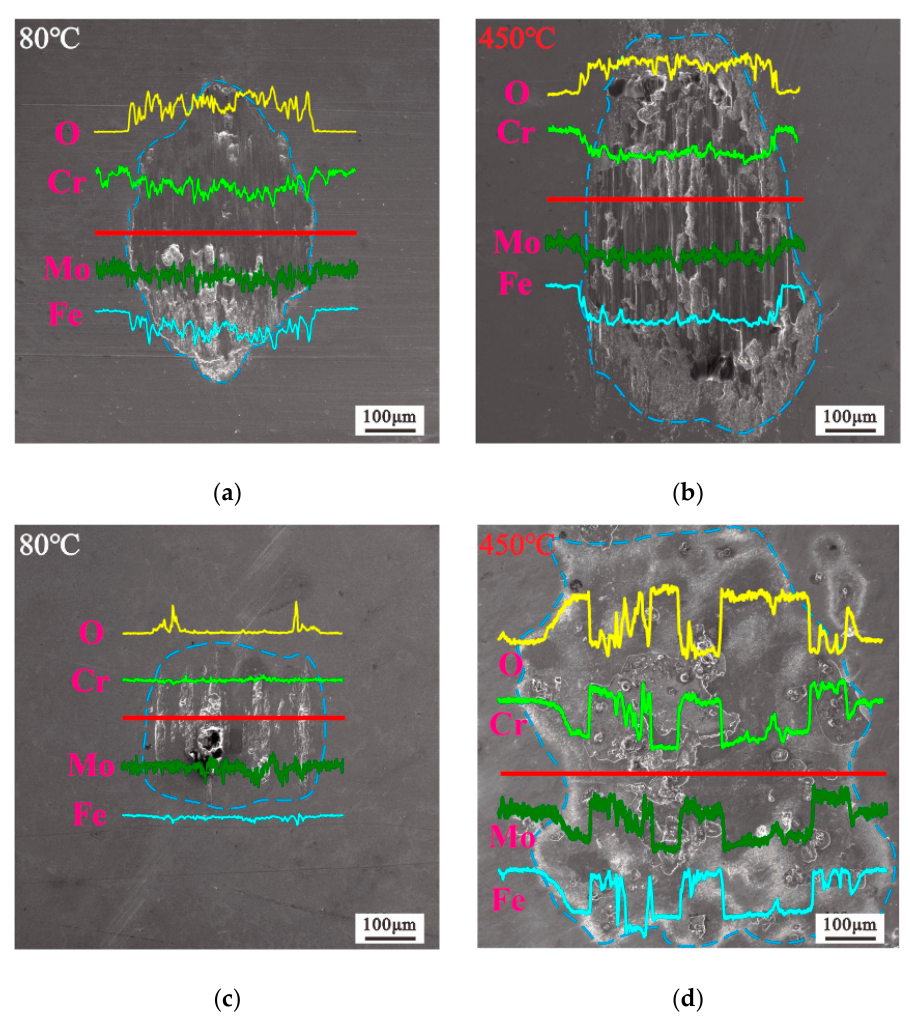
Figure 10. EDX analysis of worn scars, D = 50 μ m: ( a ), ( b ) F = 10 N; ( c ), ( d ) F = 20 N.